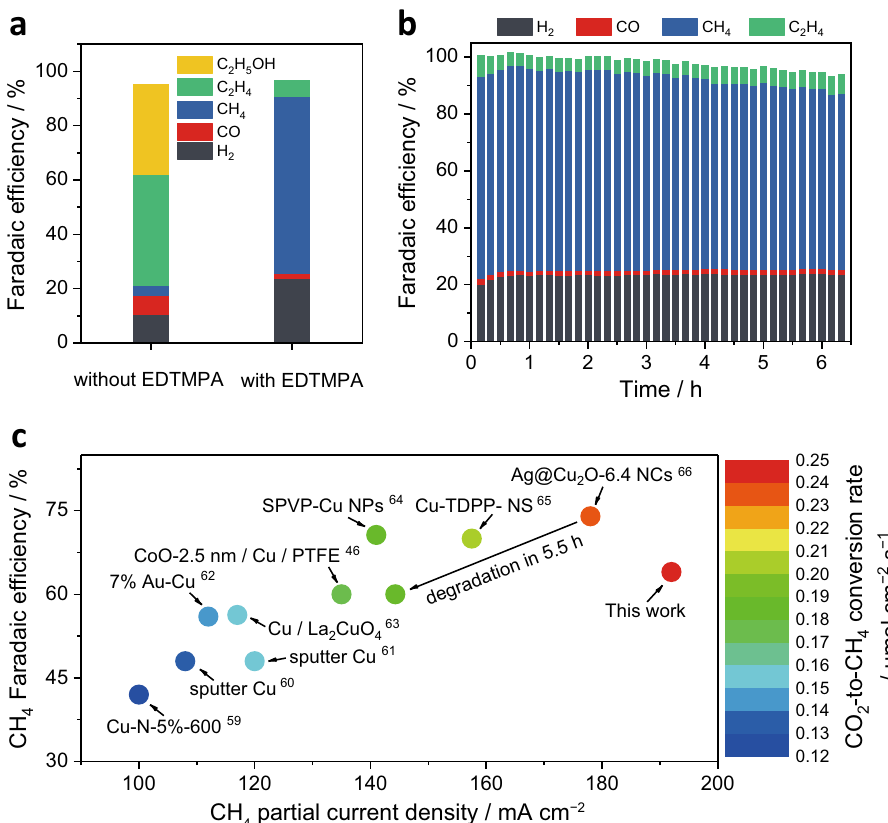
Fig. 5 CO 2 electroreduction performance in a fl ow cell. a Comparison ofthe FEs ofvarious productsat300mAcm − 2 on a poly-Cu GDE in1 M KOH withand without 13mM EDTMPA additive. b Stability test over 6 h of a poly-Cu GDE at 300 mA cm − 2 in 1M KOH with 13mM EDTMPA additive. c Comparison of our work with previous studies on the electrocatalytic CO 2 -to-CH 4 reaction in a fl ow cell with partial current densities over 100 mAcm − 2 (Refs. 46,59 – 66